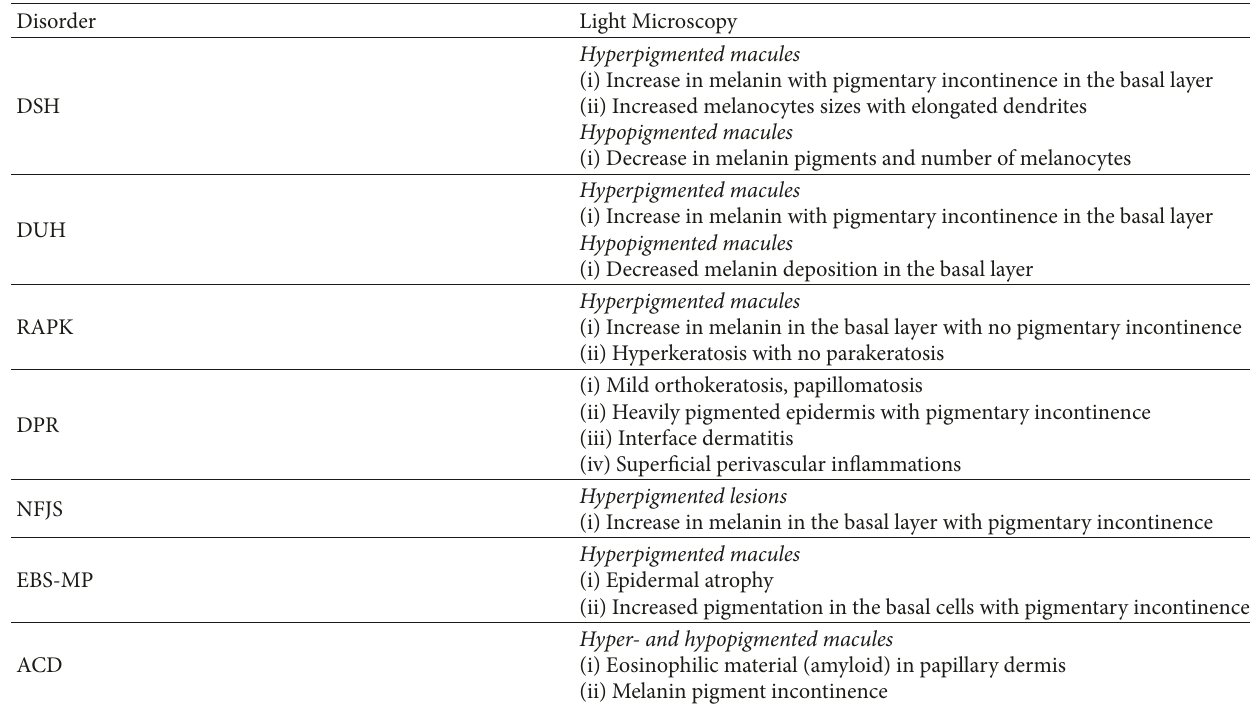
Table 3: Histopathological features, light microscopy.